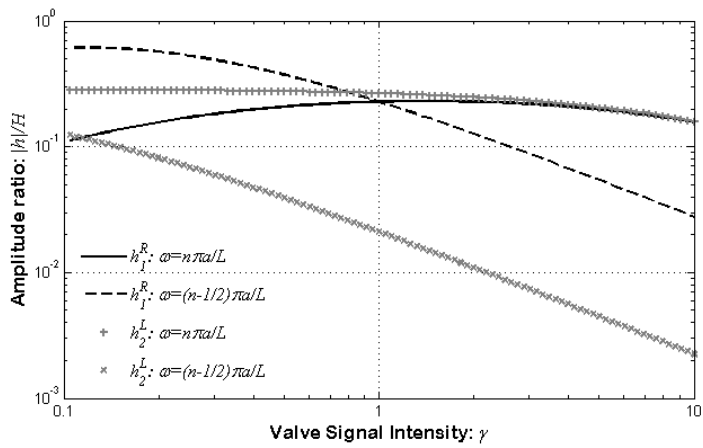
Figure 8. Impact of the Darcy–Weisbach friction factor on the resonances and anti-resonances of the upstream and downstream pressure fluctuations at VSI condition